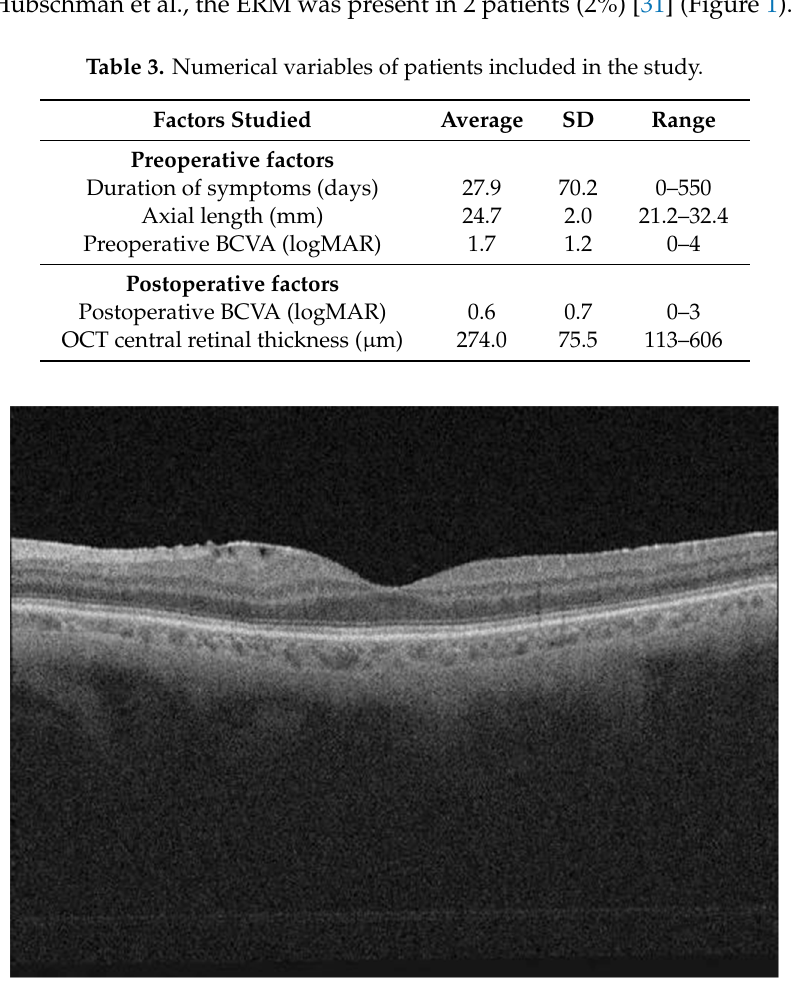
Table 4. The effect of preoperative patient-related factors on postoperative best-corrected visual acuity (BCVA).